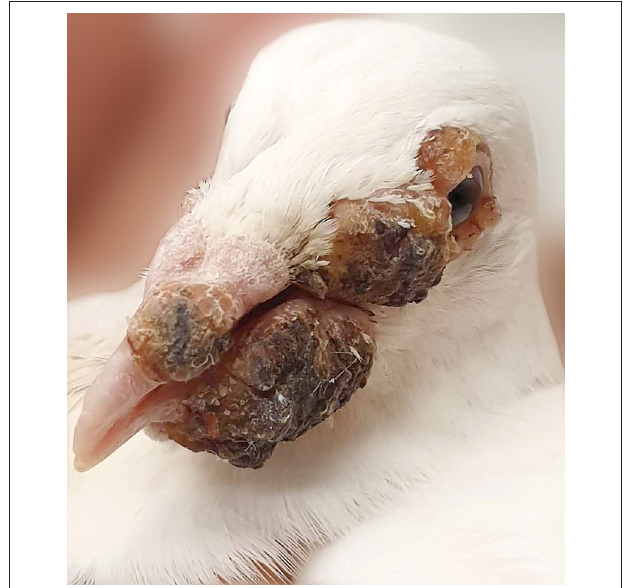
FIGURE 1 | Pox in pigeon from which multidrug-resistant E. coli and S. aureus strains were isolated: note typical yellow-to-brown nodules on and around beak and